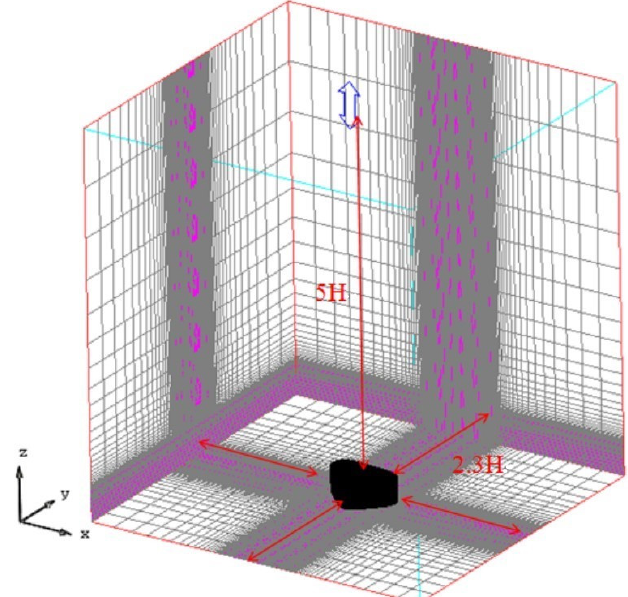
Figure 9. Computational domain.